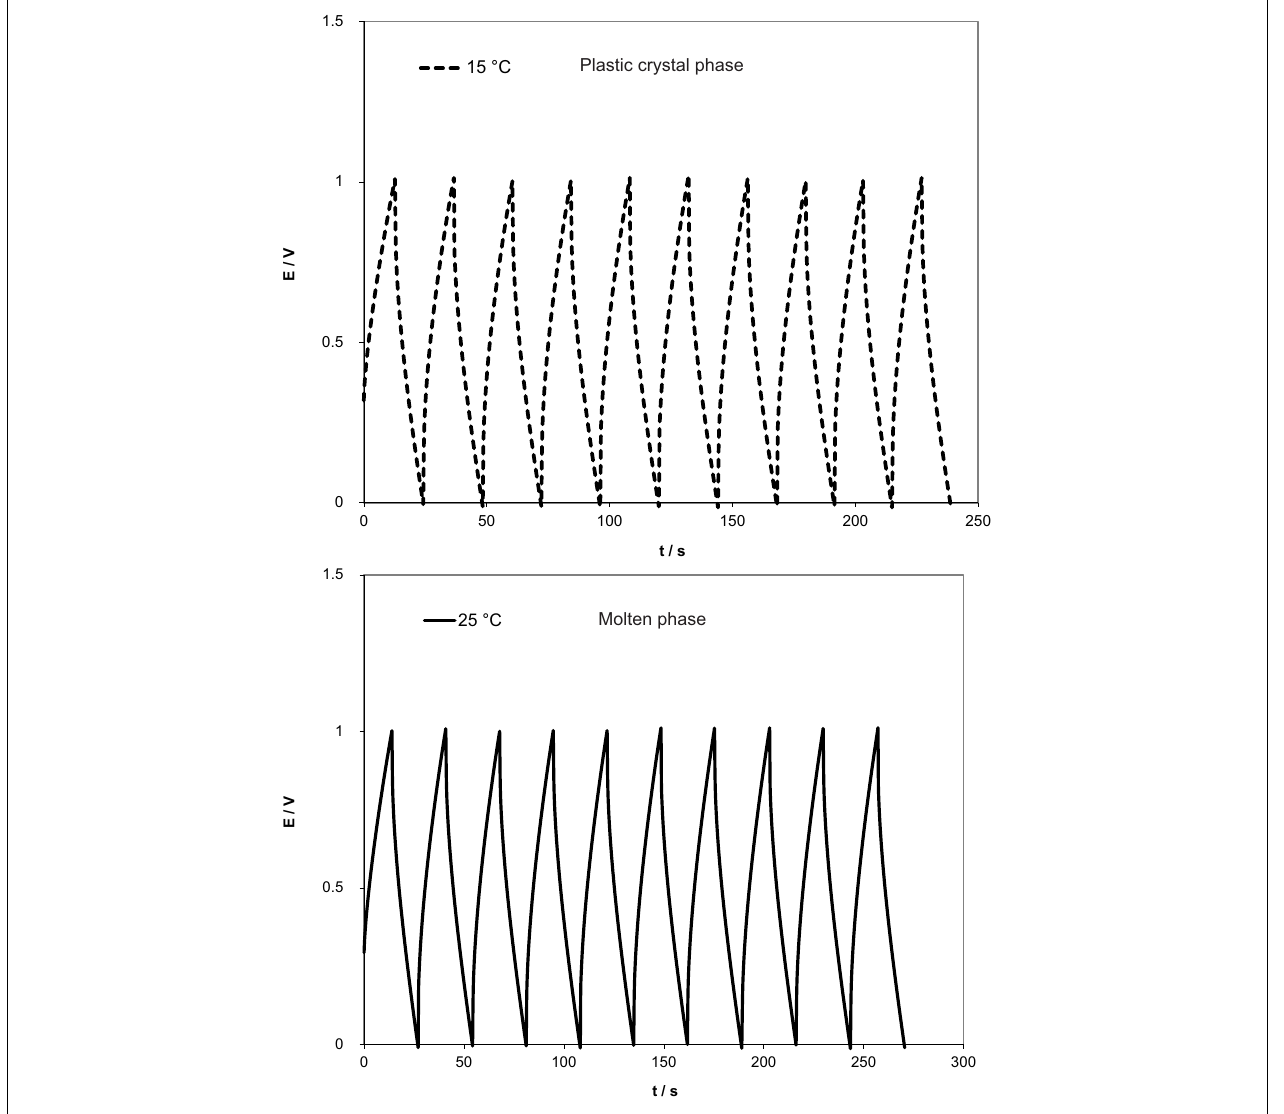
FIGURE 5 | Charge–discharge curves at 1mA for the EDLC utilizing the SCN-10%TBA-PF 6 electrolyte in the plastic phase (15°C) and the molten state (25°C) .